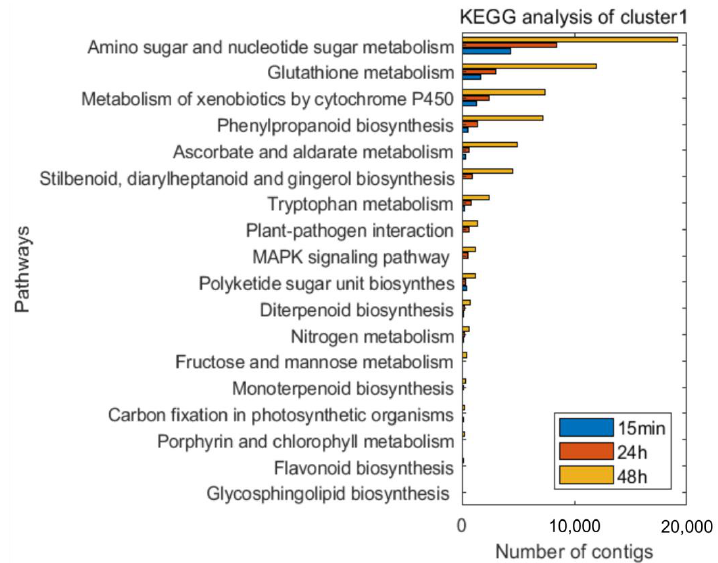
Figure 6. KEGG analysis of cluster 1 at the three investigated times, relative to the control (0 min). The expression levels of these genes gradually increase. The graph shows the numbers of transcripts that are annotated (DOI:10.17632/p66v4yxbtp.1) and can be placed into the KEGG pathway